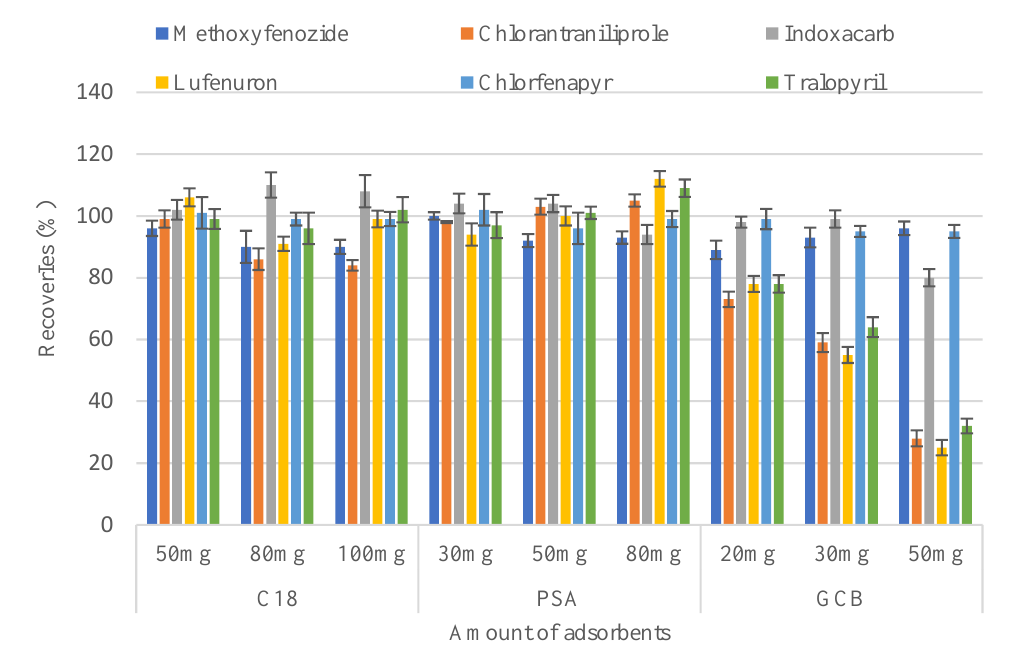
Figure 2. The recoveries of the six compounds in spinach by different adsorbents.